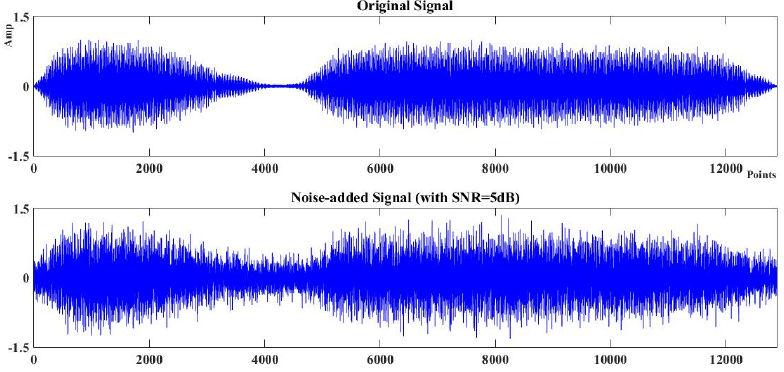
Figure 4. The original signal and white noise ‐ added signal. SNR: signal ‐ to ‐ noise ratio.